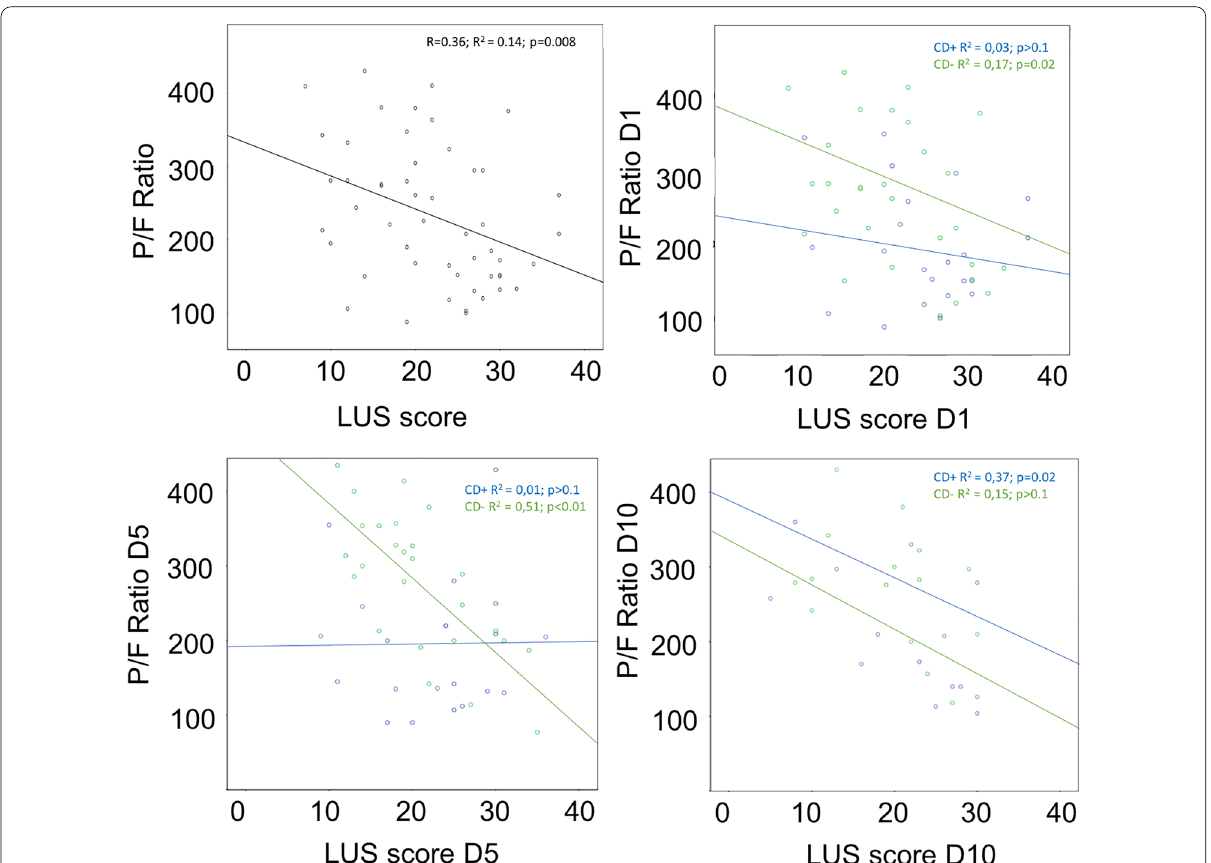
Fig. 3 Correlation between lung ultrasound (LUS) score and the arterial oxygen partial pressure times fractional inspired oxygen ratio (P/F ratio) at D1, D5 and D10 evaluation times. Linear relation showed in overall cohort (top left image) and after dividing patients according to the presence of cardiac dysfunction (CD and CD ). The number of patients included in each evaluation is shown in Table 2. Note that LUS of CD + − correlated with LUS findings at D10